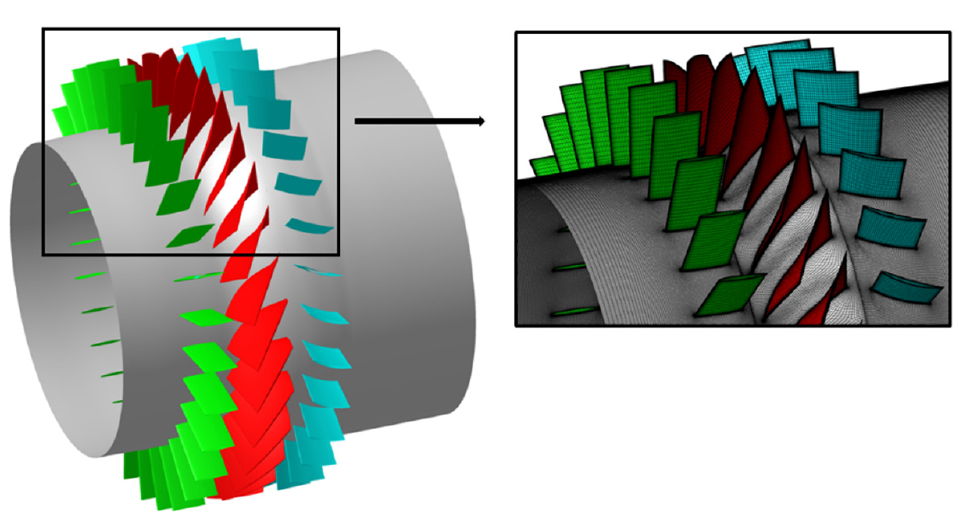
Figure 3. One passage of grid for simulation.